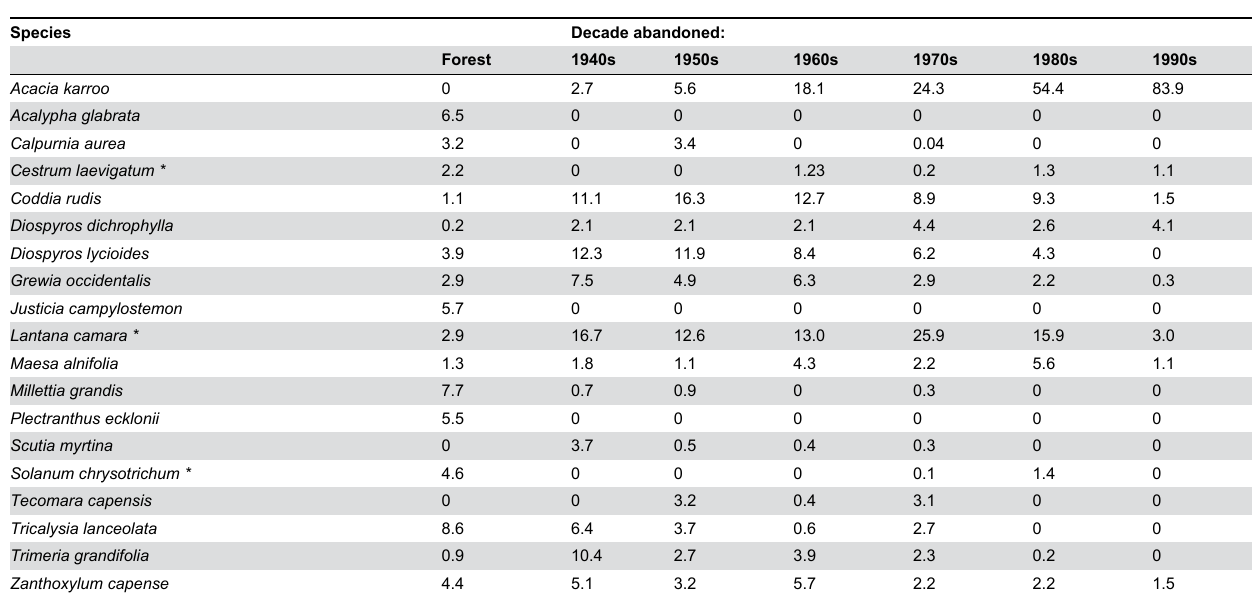
Table 2. The relative density (%) of the most common woody species in forests and across fields with different abandonment dates